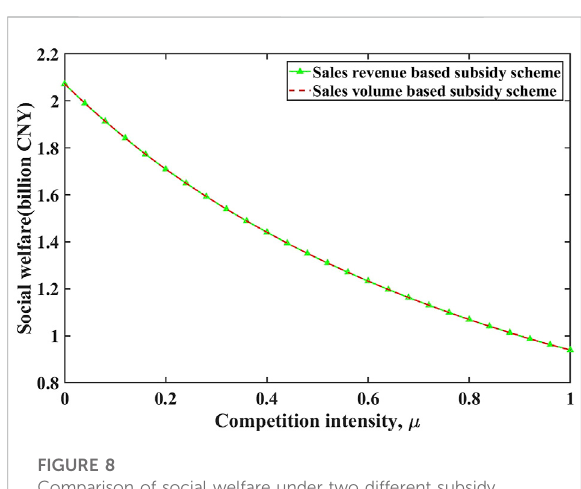
FIGURE 8 Comparison of social welfare under two different subsidy schemes.